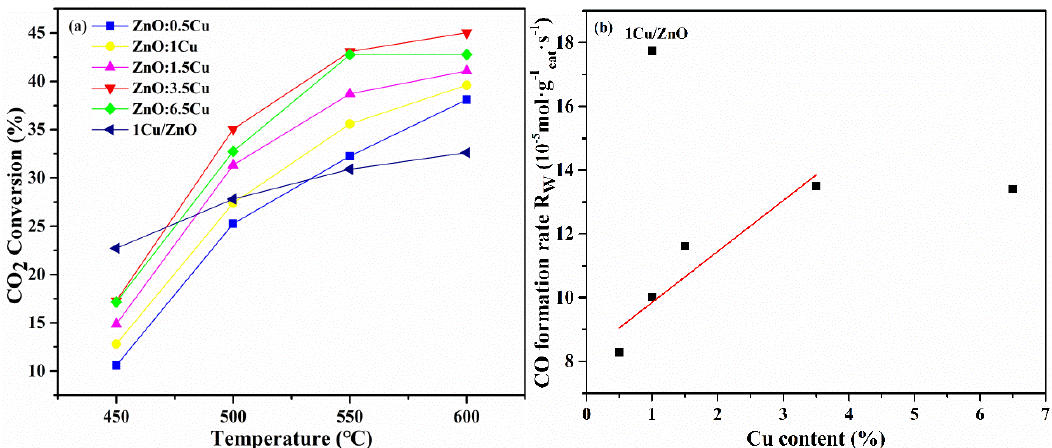
Figure 7. Catalytic performance of 1Cu/ZnO and ZnO:XCu model catalysts, X = 0.5, 1.0, 1.5, 3.5, 6.5 ( a ) and R w as a function of the amount of Cu for the reverse water gas shift (RWGS) reaction at 450 °C ( b ).